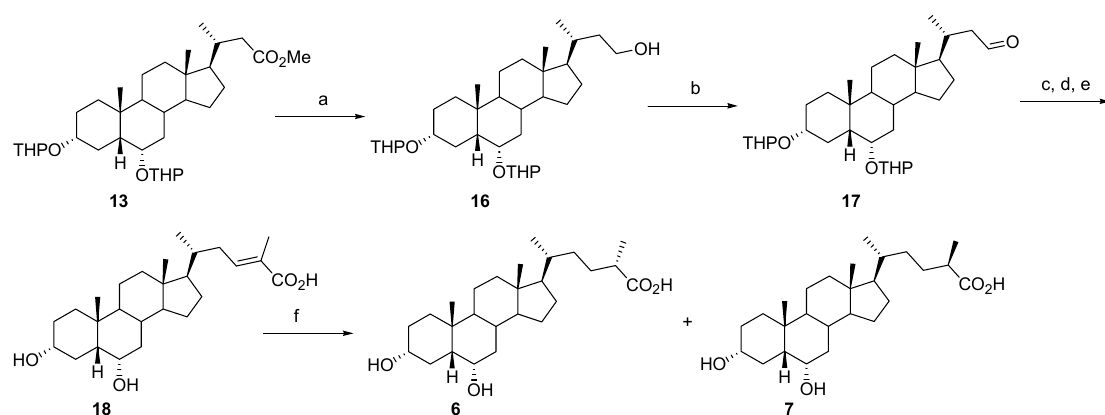
-methyl HDCA derivatives 6 – 7 24